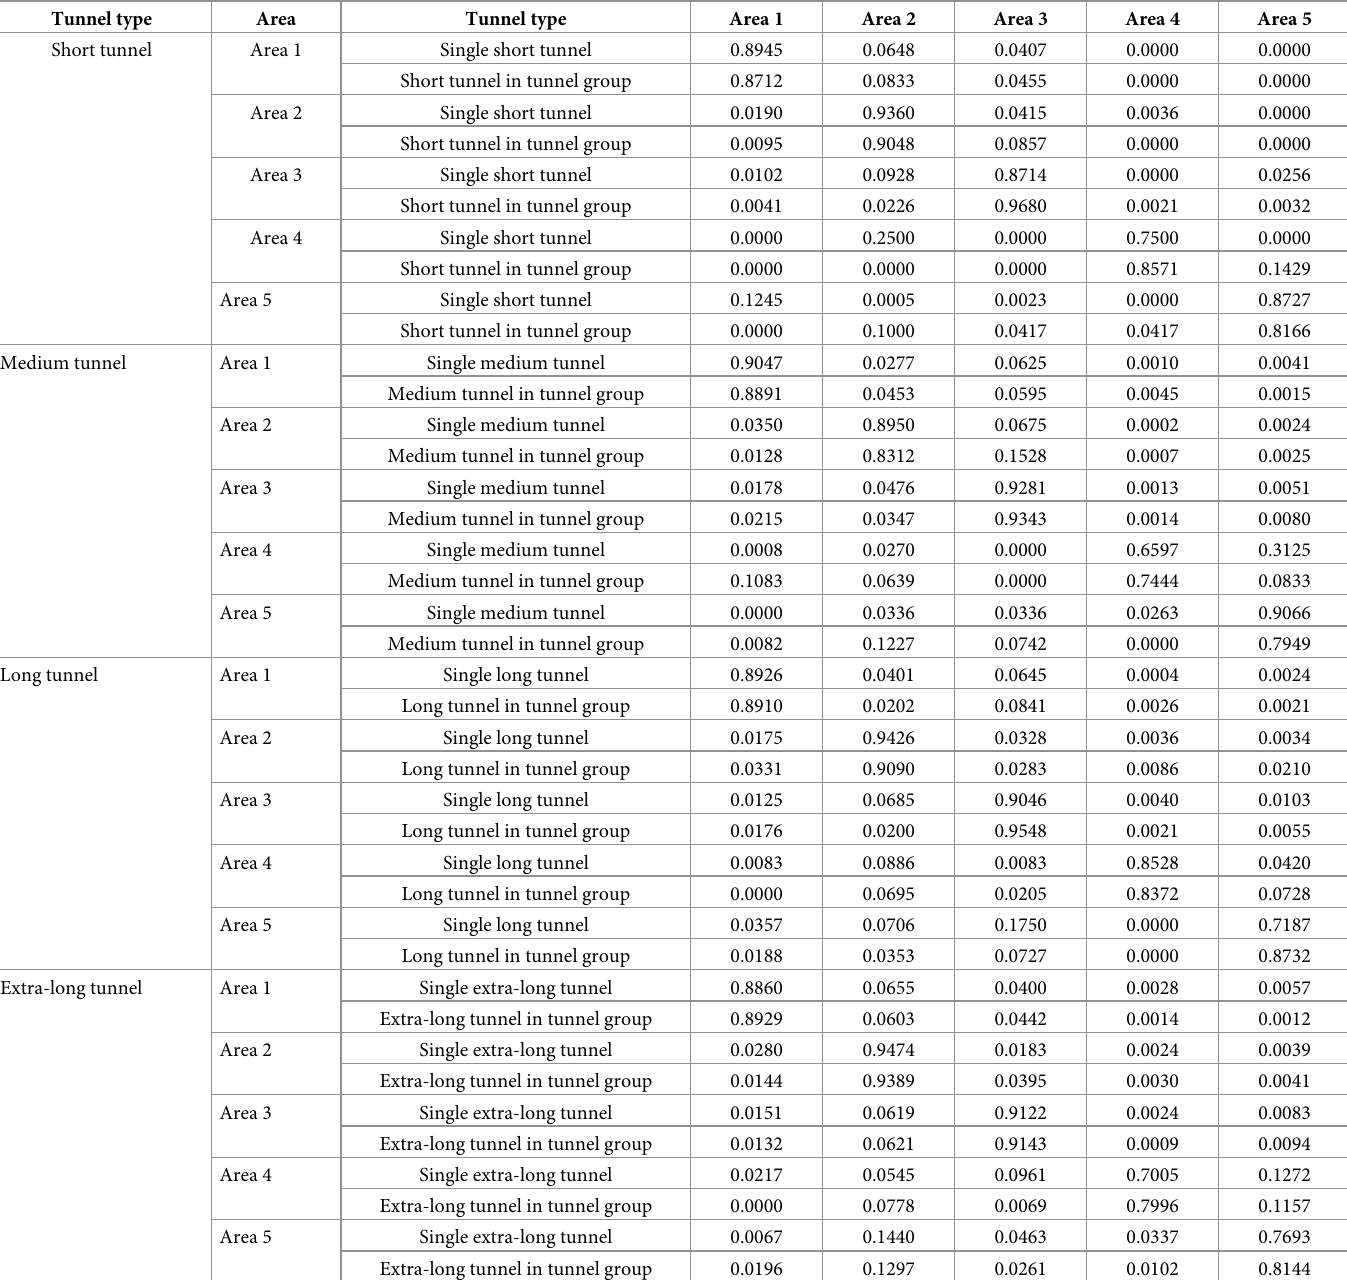
Table 2. One-step transition probability matrix of different type